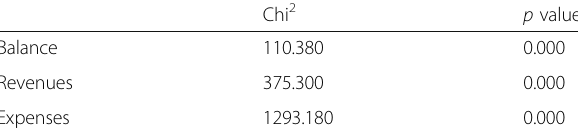
Table 5 Covariance between the potentially endogenous